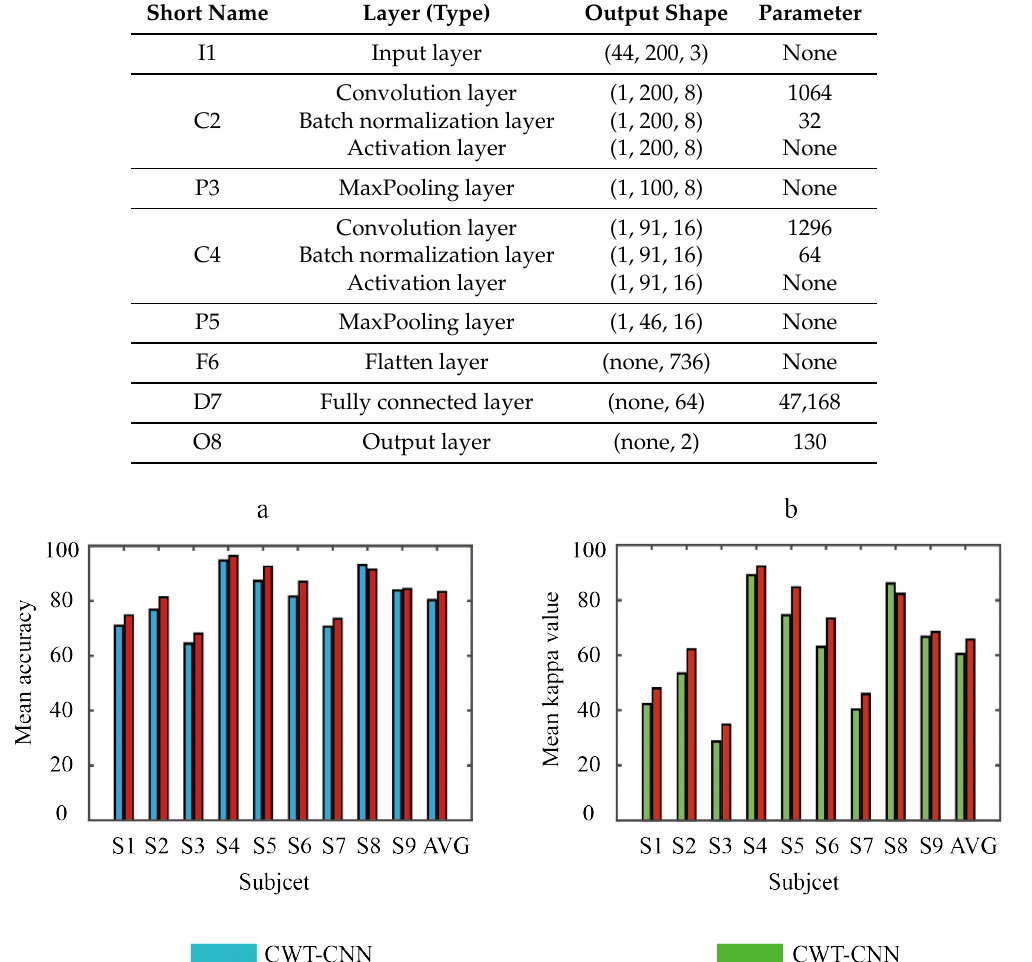
Table 6. The output matrix size and network parameters of each layer of the formed standard CNN.